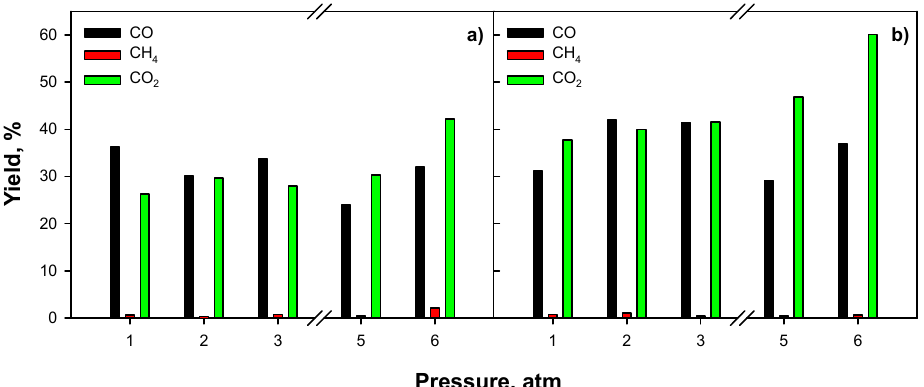
Figure 14. Yields to CO, CH 4 , and CO 2 as a function of pressure during steam reforming of AZ mixture on 5 Ni monolith at 720 °C; gas-phase feed composition: Solvent/H 2 O/N 2 = 0.7/4/95.3 for H 2 O/C = 2 ( a ); solvent/H 2 O/N 2 = 0.7/6/93.3 for H 2 O/C = 3 ( b ).